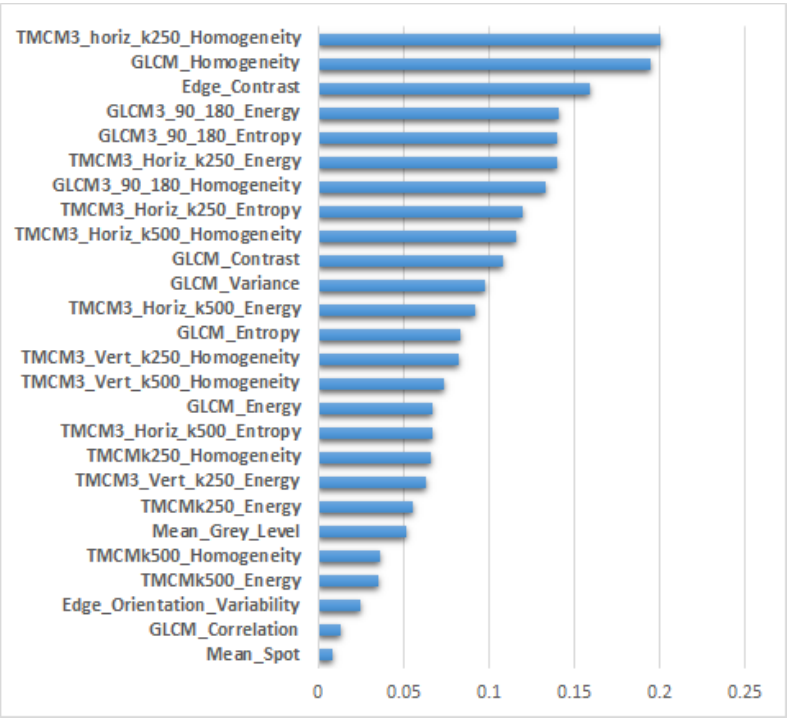
Figure 7. The ranking of the most relevant textural features through the combined feature vector for the GE9